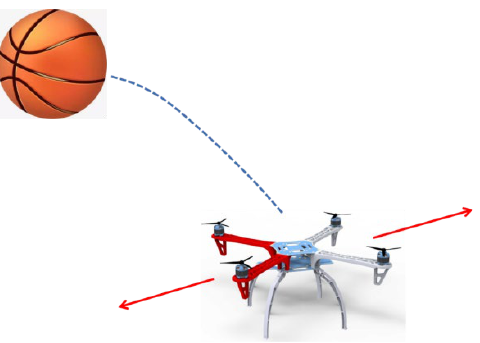
Figure 11. UAV avoiding flying basketball task.